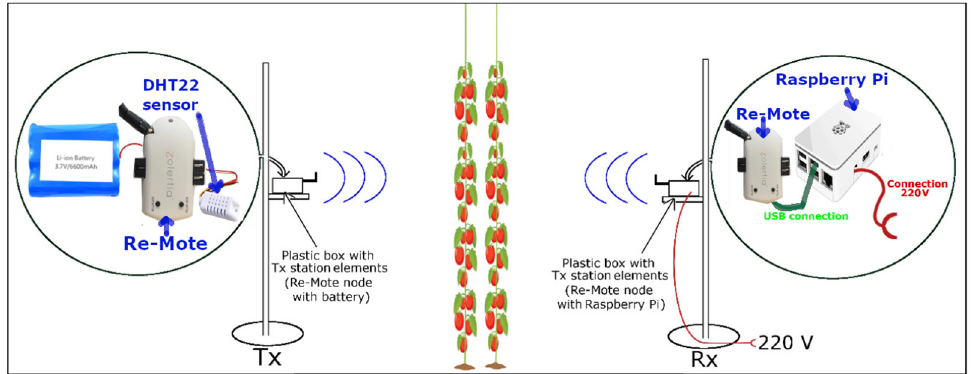
Figure 2. Wireless communication scheme of Tx and Rx stations in a tomato greenhouse. Tx station ( left ) powered by Lithium-ion 3.7 V-6600 mAh battery. Rx station ( right ) connected to a Raspberry Pi embedded computer.